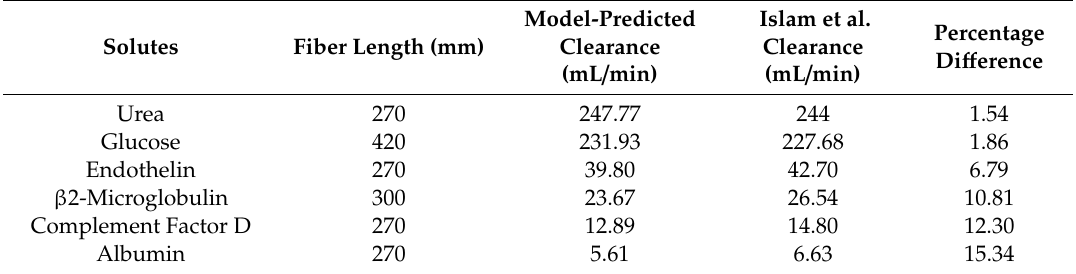
Table 6. Maximum percentage difference of this model with literature data at varying dialyzer fiber length [22].